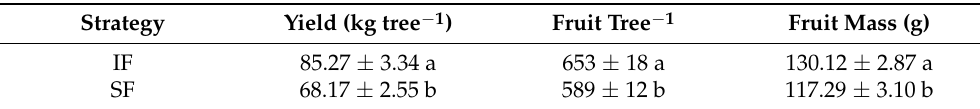
Table 2. Effect of standard fertigation (SF) and intensive fertigation (IF) on yield (kg tree − 1 ), number of fruits per tree (fruit tree − 1 ) and fruit mass (g) in the early harvest. Different lowercase letters show significant differences among treatments.